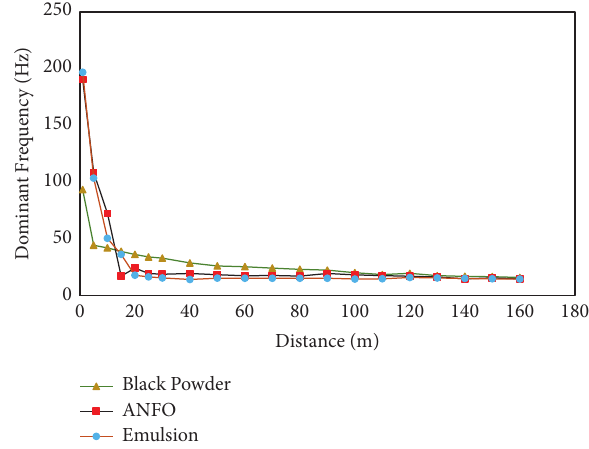
Figure 12: The dominant frequency diagram versus distance from the blast site for different